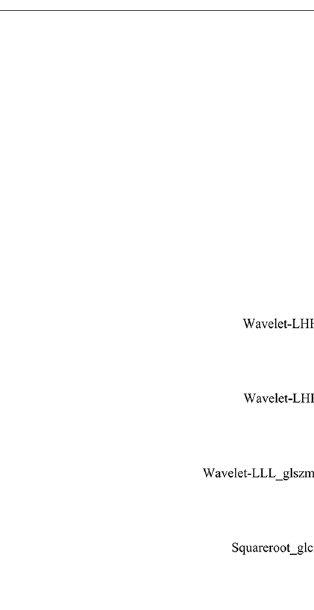
FIGURE 5 | The correlation heat map of radiomics features. Red indicates positive correlation, and blue indicates negative correlation; the darker the color, the stronger the relationship.